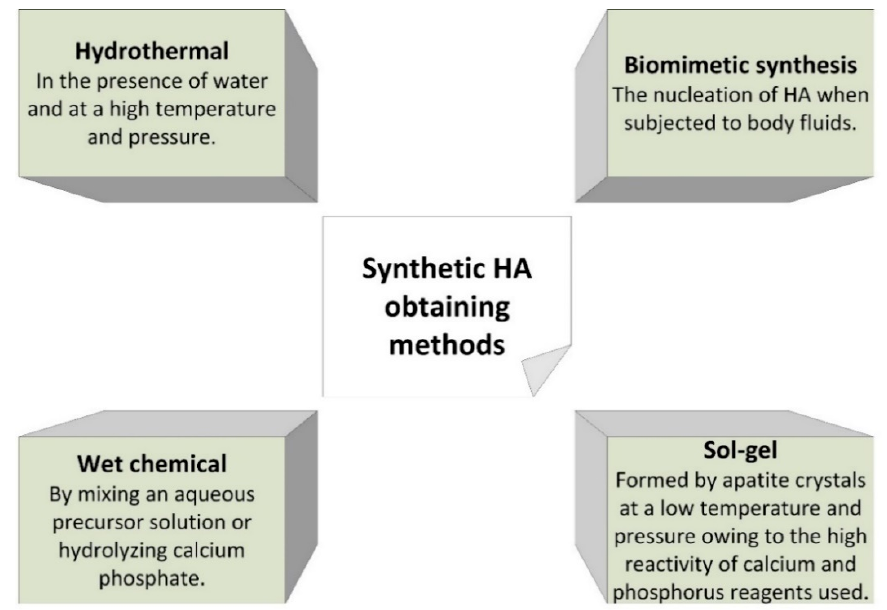
Figure 4. Synthetic HA obtaining methods. Realized based on [4].